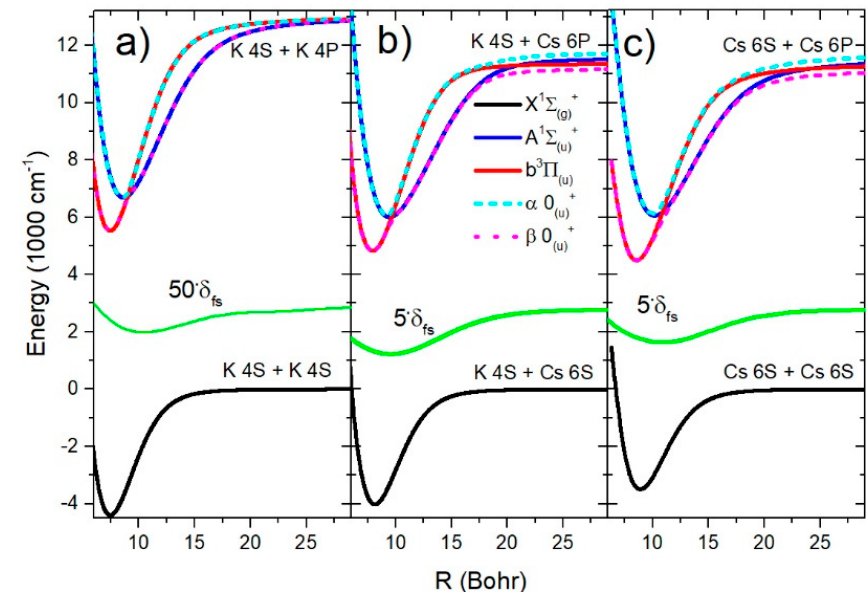
Figure 3. The electronic states’ potentials curves relevant for the analysis of the infrared spectra of K 2 , KCs, and Cs 2 molecules are shown in ( a – c ), respectively. The green curve shows the spin–orbit splitting function δ fs ( R ) responsible for the coupling of the A and b states.